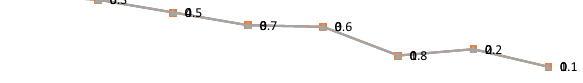
Figure 5. Participation % of the tourism return form GDP during 2008/